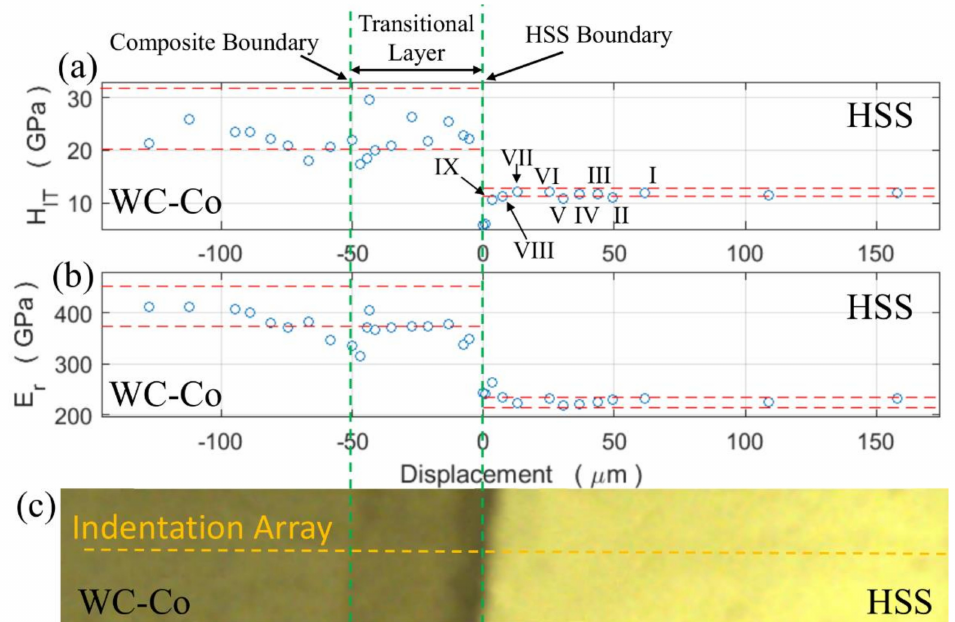
Figure 20. Indentation hardness ( a ) and reduced modulus ( b ) vs. displacement along the nIIT array across a wide (about 50 µ m) transitional layer. The red dashed lines show the ranges of indentation hardness and reduced modulus characteristics of the base materials, ( c ) is the optical microscopy image taken from the positioning system of the nano-indenter machine. The Roman numerals indicate nine nano-indentation imprints on the HSS side, according to Figure 18. The green dashed lines indicate the composite and the HSS side boundaries of the transitional